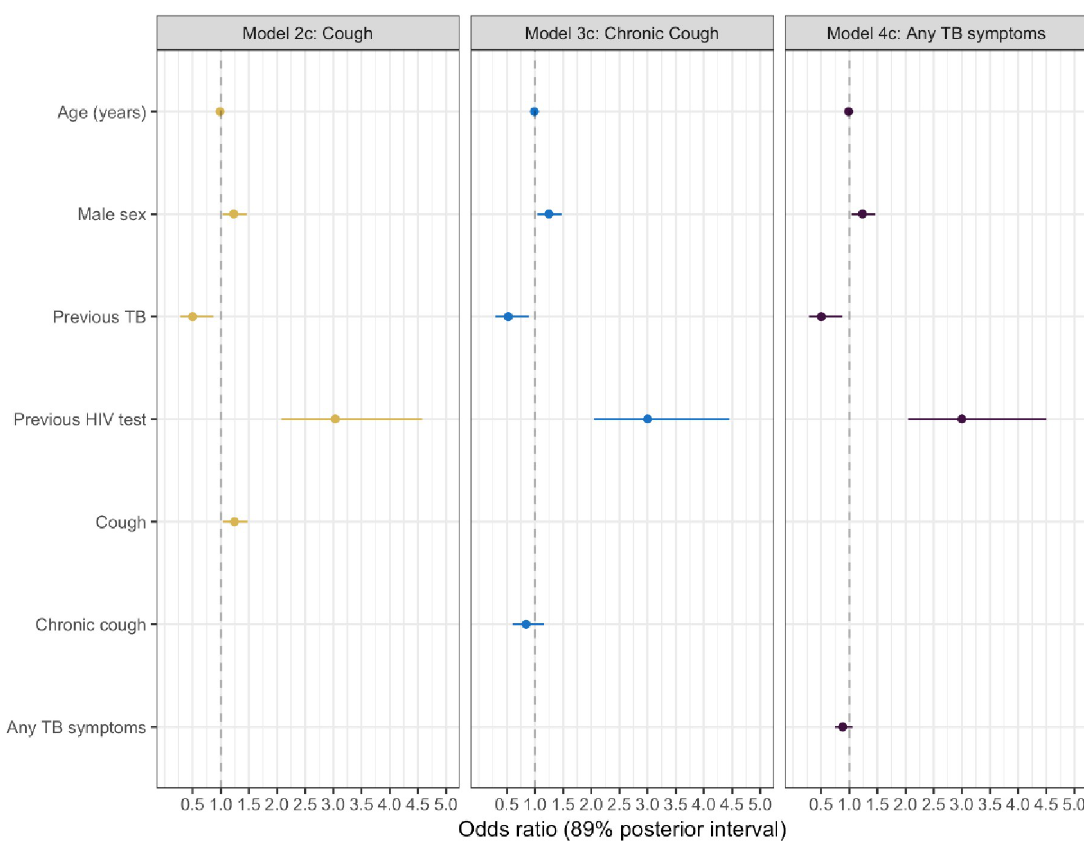
Fig 2. Model posterior probabilities for completing HIV testing during clinic attendance for individuals with and without TB symptoms.